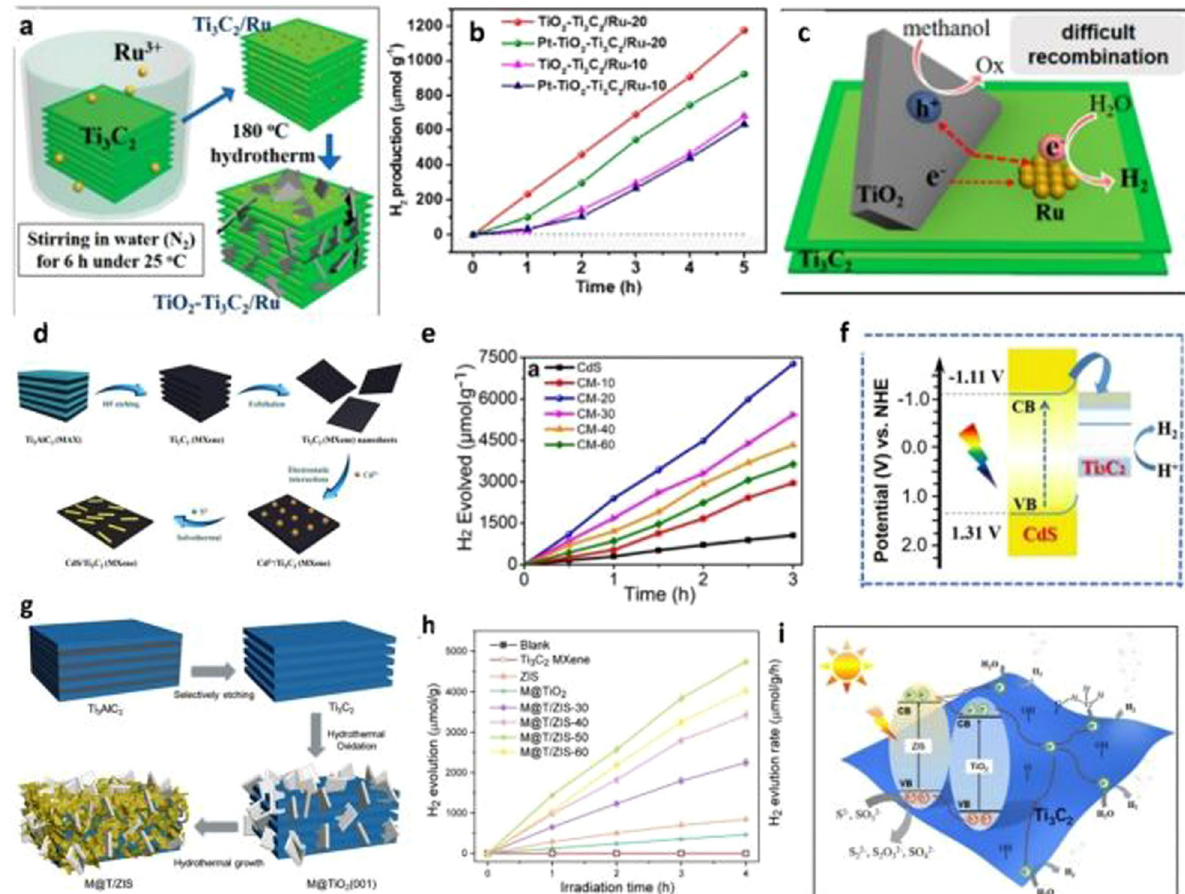
Fig. 7 MXene based photocatalysts. a Schematic synthesis steps to developed TiO 2 – Ti 3 C 2 /Ru, b photocatalytic H 2 production trend of the different catalysts, c graphical representation of transportation paths of electron − hole pairs on TiO 2 – Ti 3 C 2 /Ru composite catalyst. a –